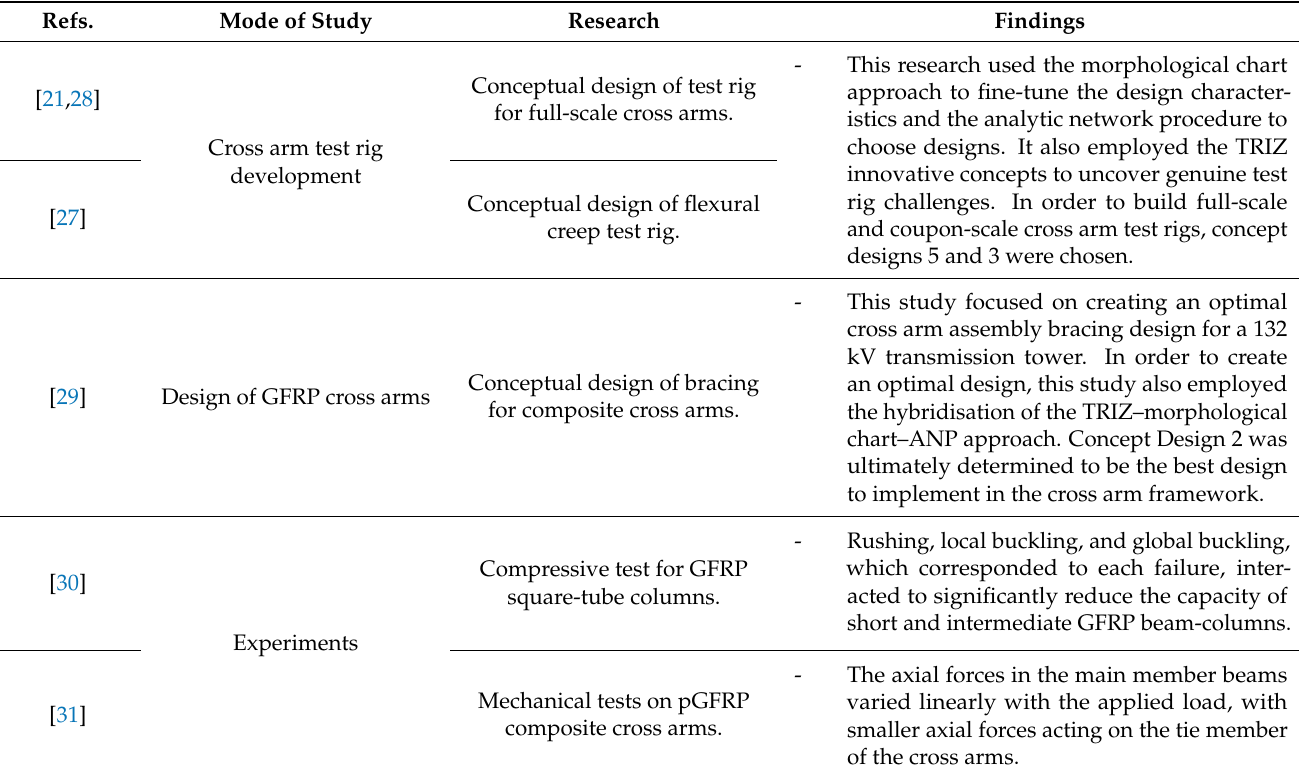
Table 1. Current research progress of pGFRP composite cross arm